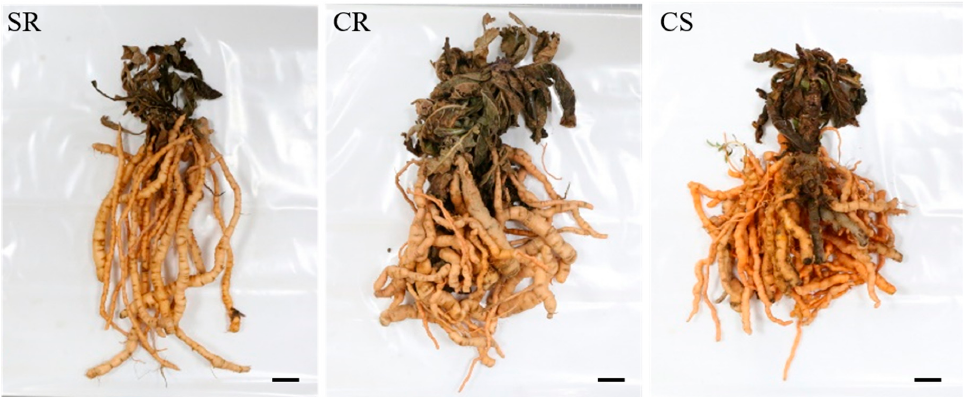
Figure 3. Comparison of root morphology of the different seedling types. SR, Standard Rootstock seedling. CR, Culture Rootstock seedling. CS, Culture seedling. The scale bar indicates 1.0 cm. The length of the R. glutinosa tuberous root was found to be the highest for SR, while CS was found to have the shortest root length. Statistical differences were only significant between SR and CS root lengths (Figure 4). The fresh weight of the tuberous root was highest for CR seedlings, while SR seedlings had the lowest weight. The dry weight of the tuberous root was found to be proportional to the fresh weight. The surface area of the tuberous root was the highest for CR (46 cm 2 ). The second highest area was measured for CS at 39.6 cm 2 . SR was found to have the lowest surface area among the three seedling types with an average surface area of 30.3 cm 2 (Table 2). Figure 4. Comparison of the development of the subterranean parts of the three different types of R. glutinosa seedlings (SR, CS, and CR). The indicated statistical differences were calculated using two- way ANOVA and Bonferroni’s post-hoc test: ** p < 0.01. N = 5. Table 2. Comparison of root yields of the different seedling types of R. glutinosa (SR, CR, and CS). Growth Characteristics